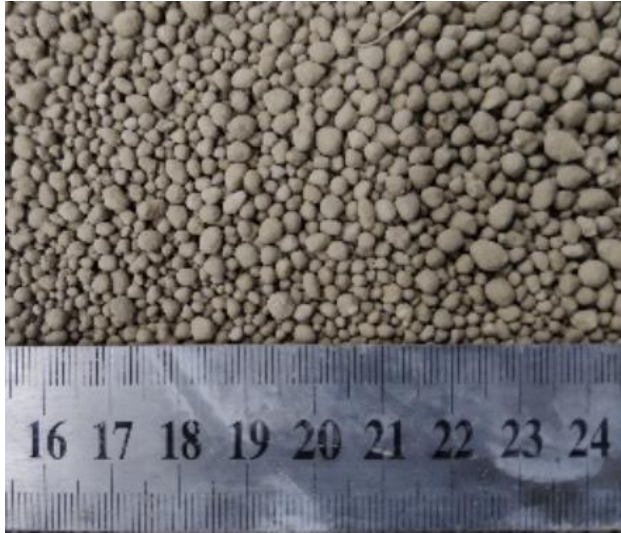
Figure 1. The artificial-functional-carrier-encapsulated bacteria.